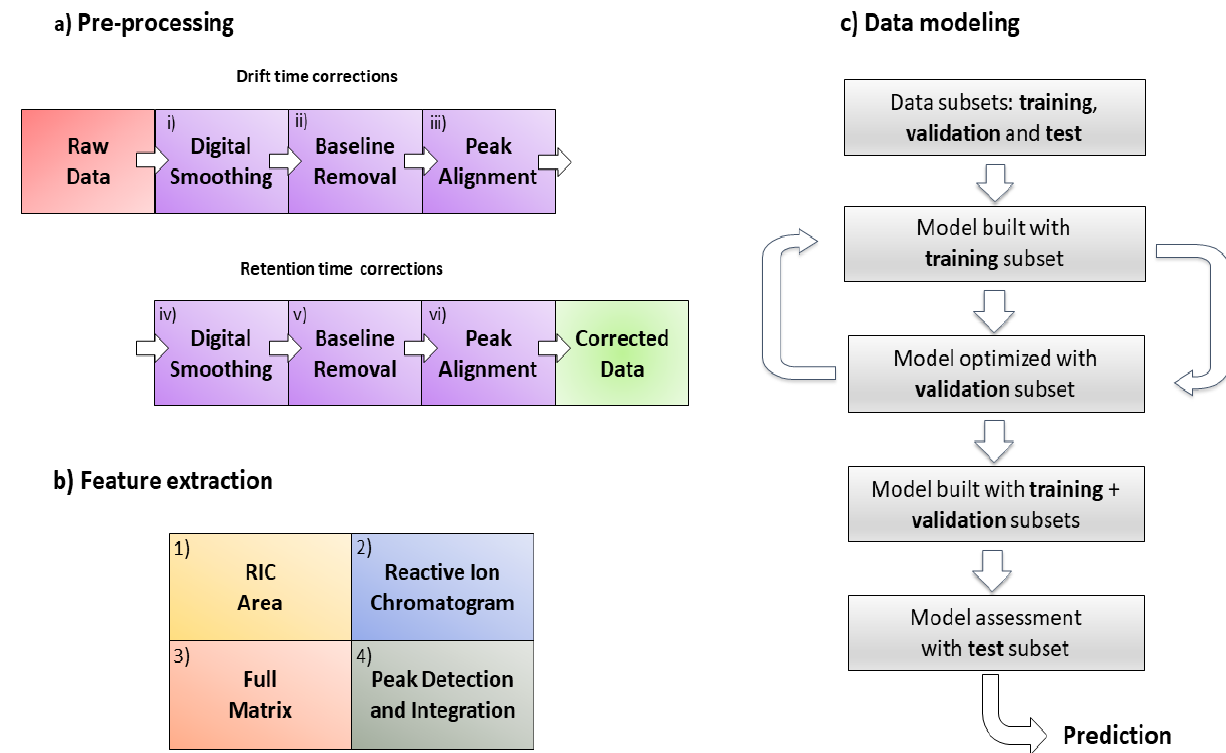
Figure 1. ( a ) Pre-processing workflow steps from raw data to the final matrix used; ( b ) feature extraction methods; ( c ) data modeling using PLS-DA. The first sample of the dataset was selected as a reference to correct the rest of the dataset in ( a).